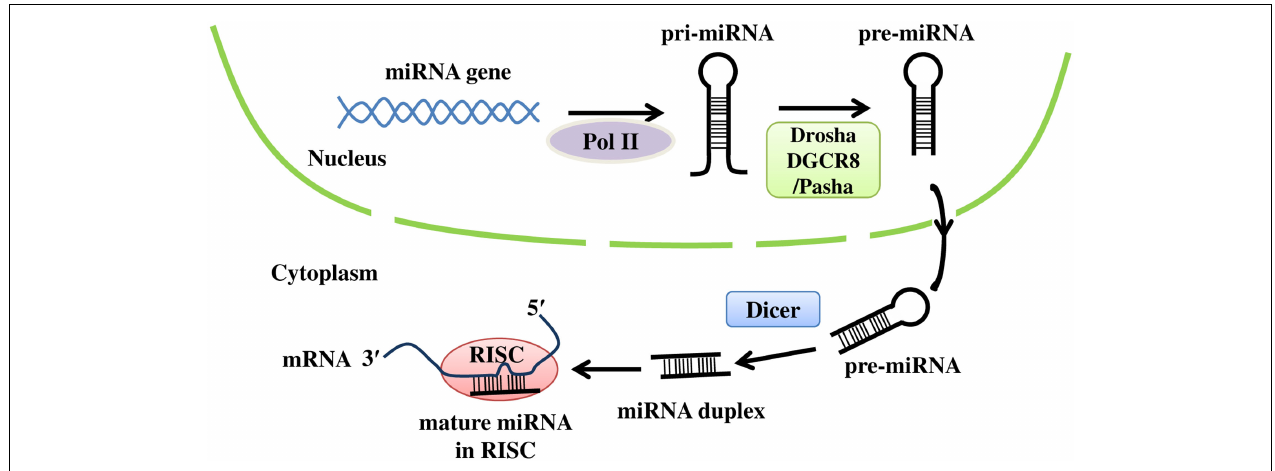
miRNA (pre-miRNA). After pre-miRNA is exported into the cytoplasm, Dicer cleaves pre-miRNA to generate the mature miRNA duplex. Finally, the mature miRNA is loaded into RISC, where it binds to the 3 (cid:2) UTR of target